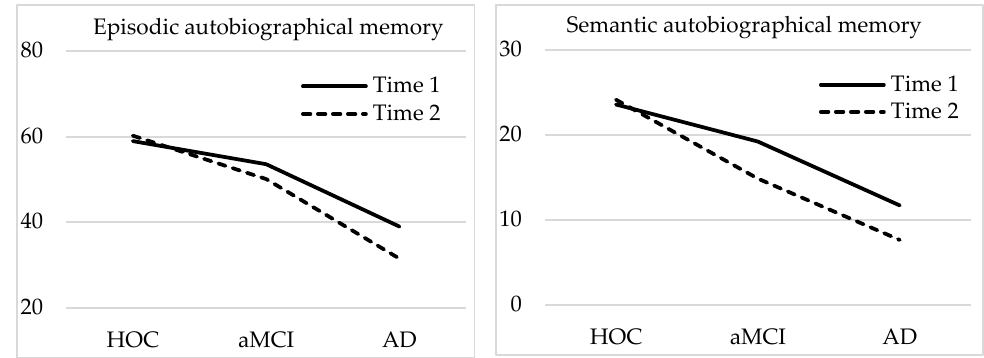
Figure 1. Mean scores for semantic and episodic autobiographical memory obtained at Time 1 and Time 2 by the different study groups.